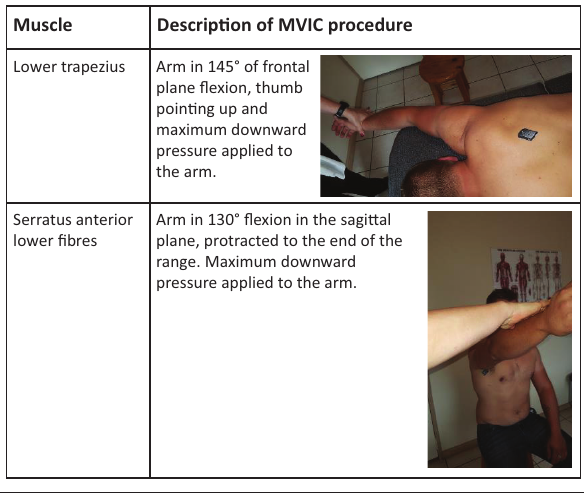
FIGURE 1: Muscle description and testing